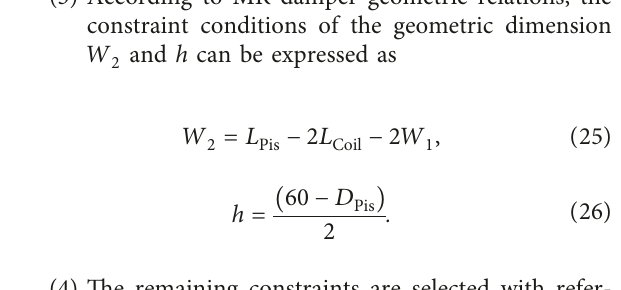
Figure 7: Relationship between B and H [26].